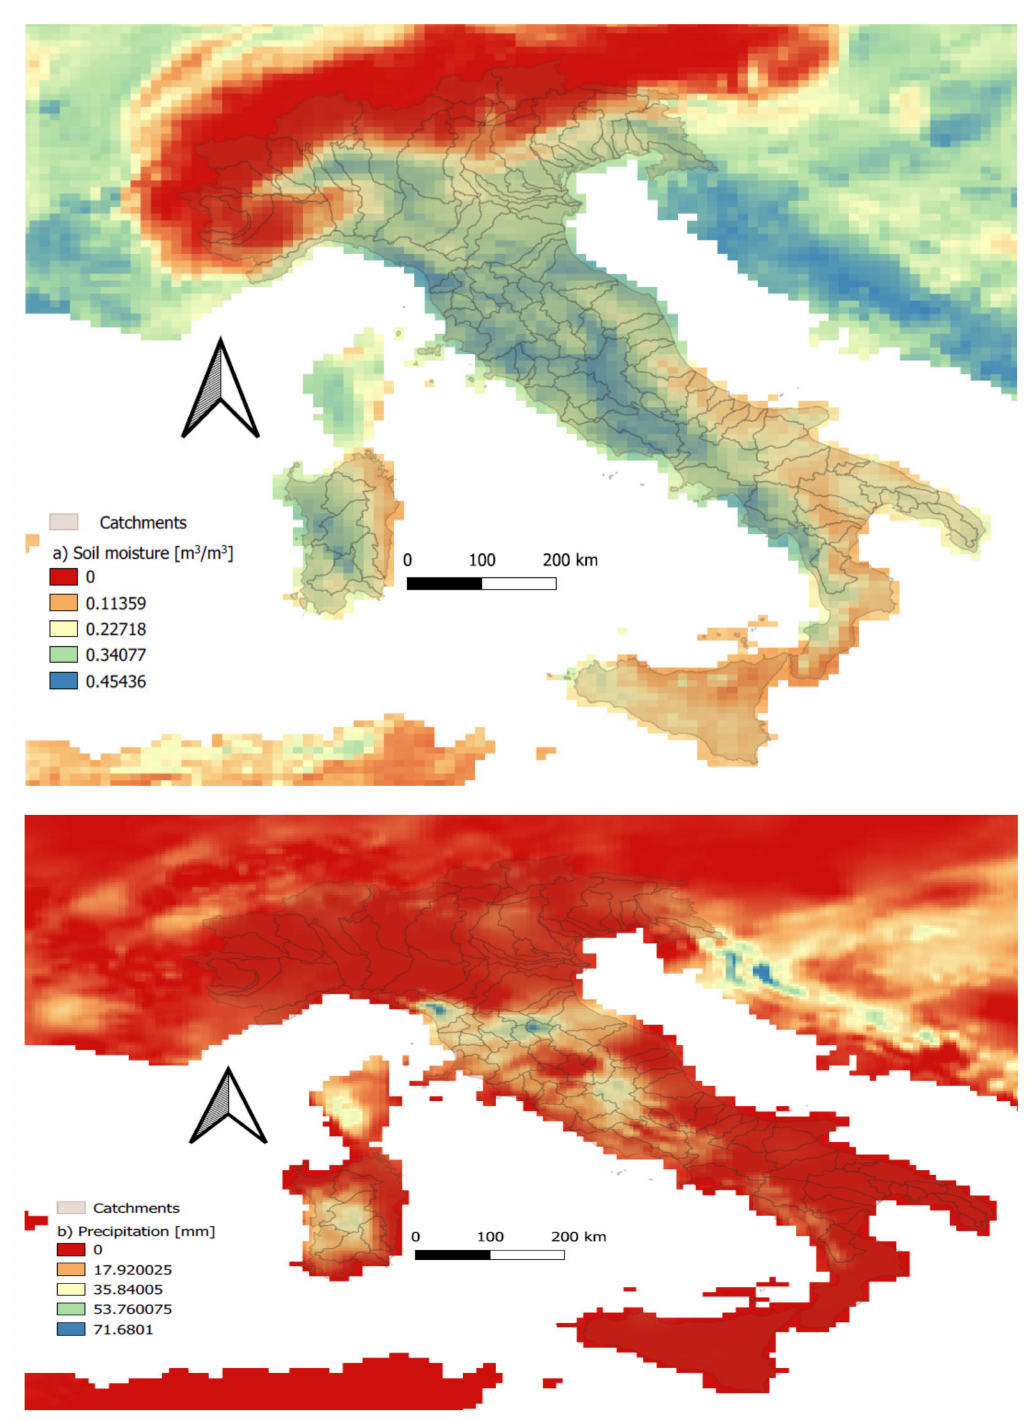
Figure 2. Example of volumetric soil moisture (VSM) ( a ) and total precipitation ( b ) data on 1 January